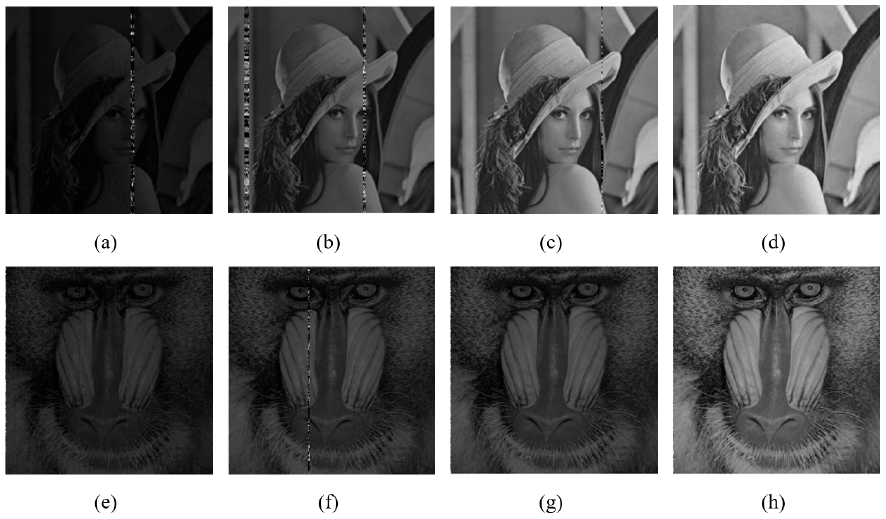
Figure 11. The reconstruction quality of the images of Lena and baboon under different compression ratios. The compression ratios of ( a ) and ( e ) are 8, ( b ) and ( f ) are 4, ( c , g ) are 2, ( d , h ) are 1.33.